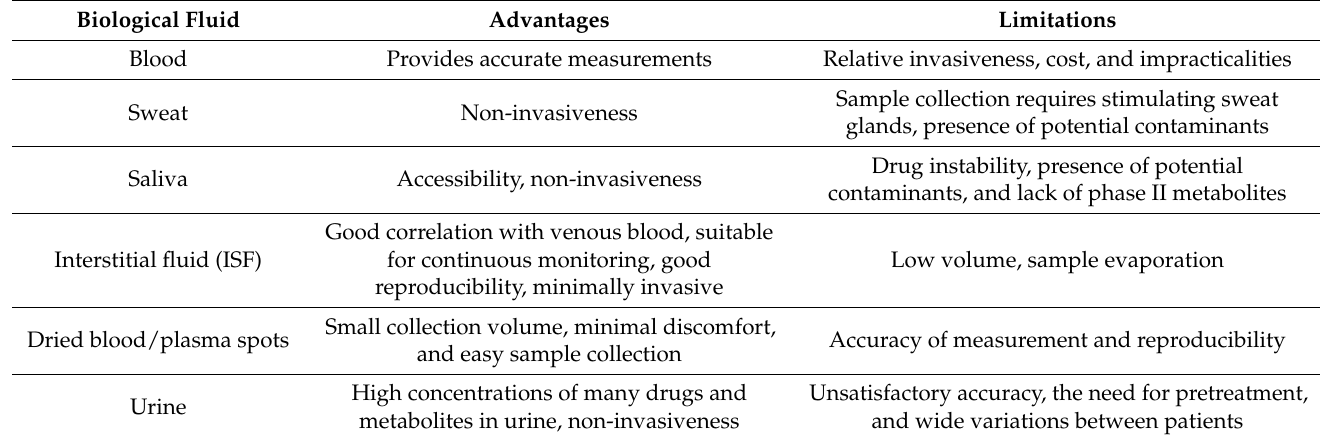
Table 1. Advantages and limitations of different biological fluids for therapeutic monitoring of